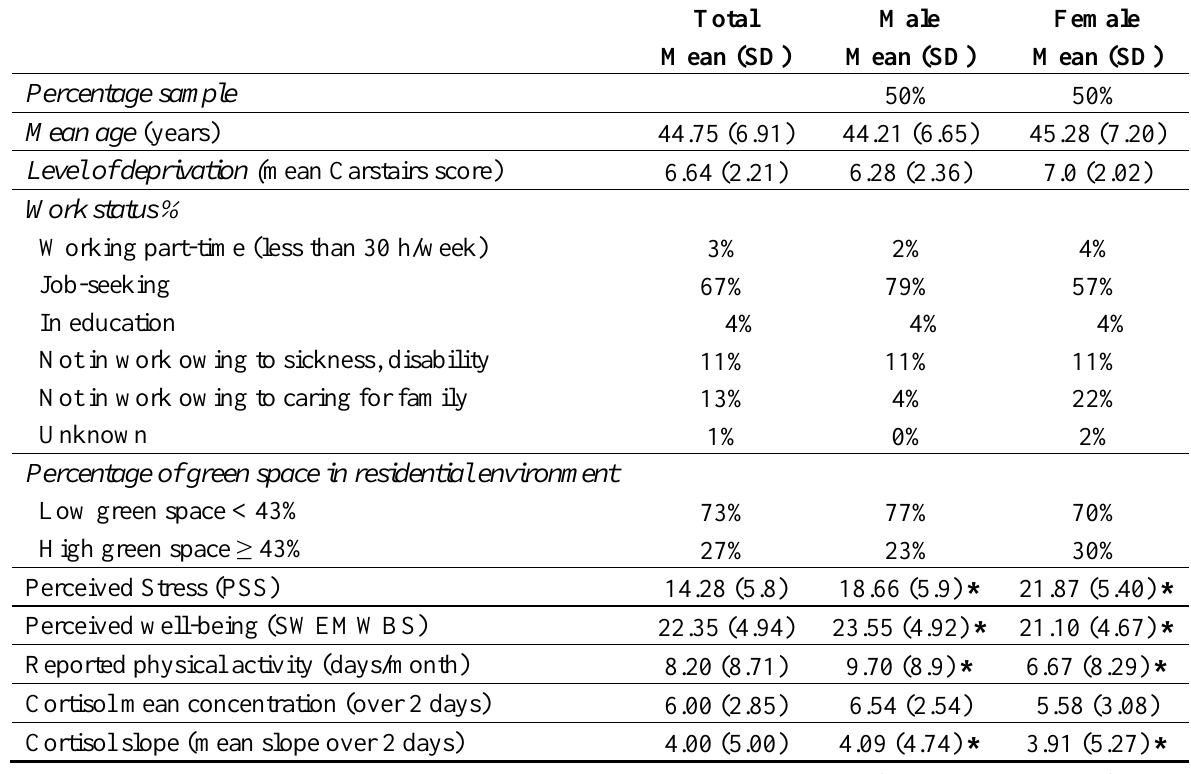
Table 1. Characteristics of the study population (n =